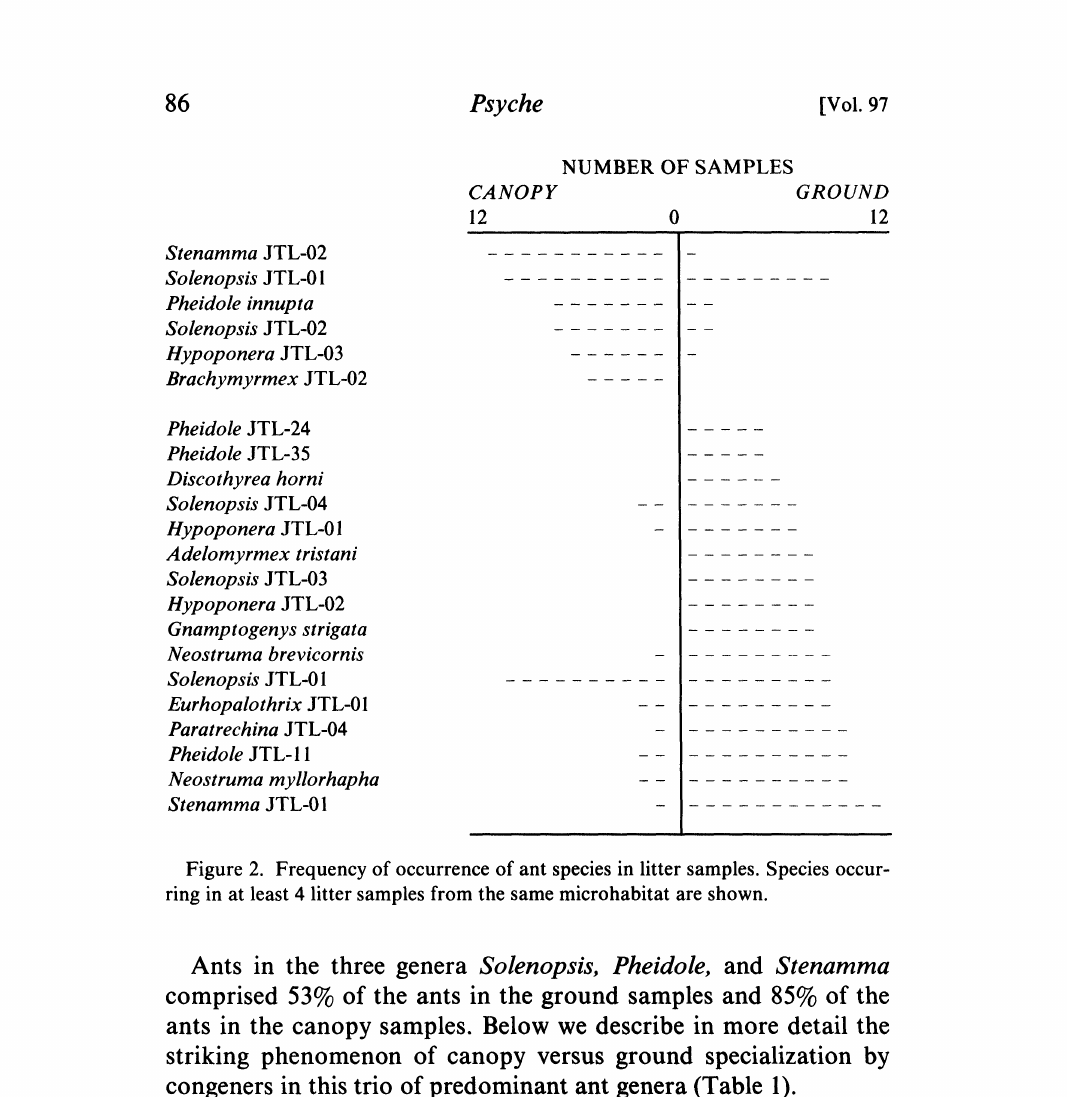
Figure 2. Frequency of occurrence of ant species in litter samples. Species occur- ring in at least 4 litter samples from the same microhabitat are